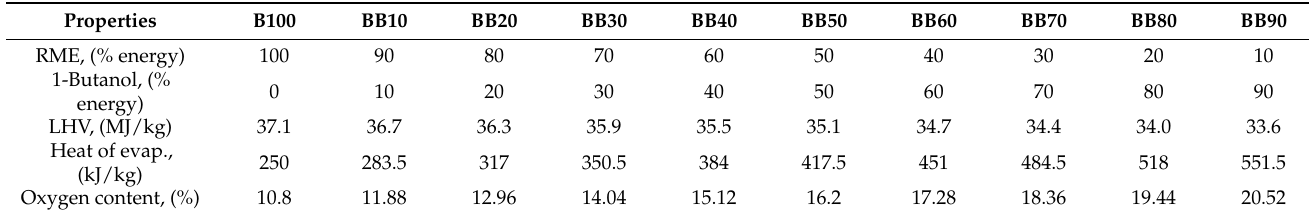
Table 4. Composition of fuel